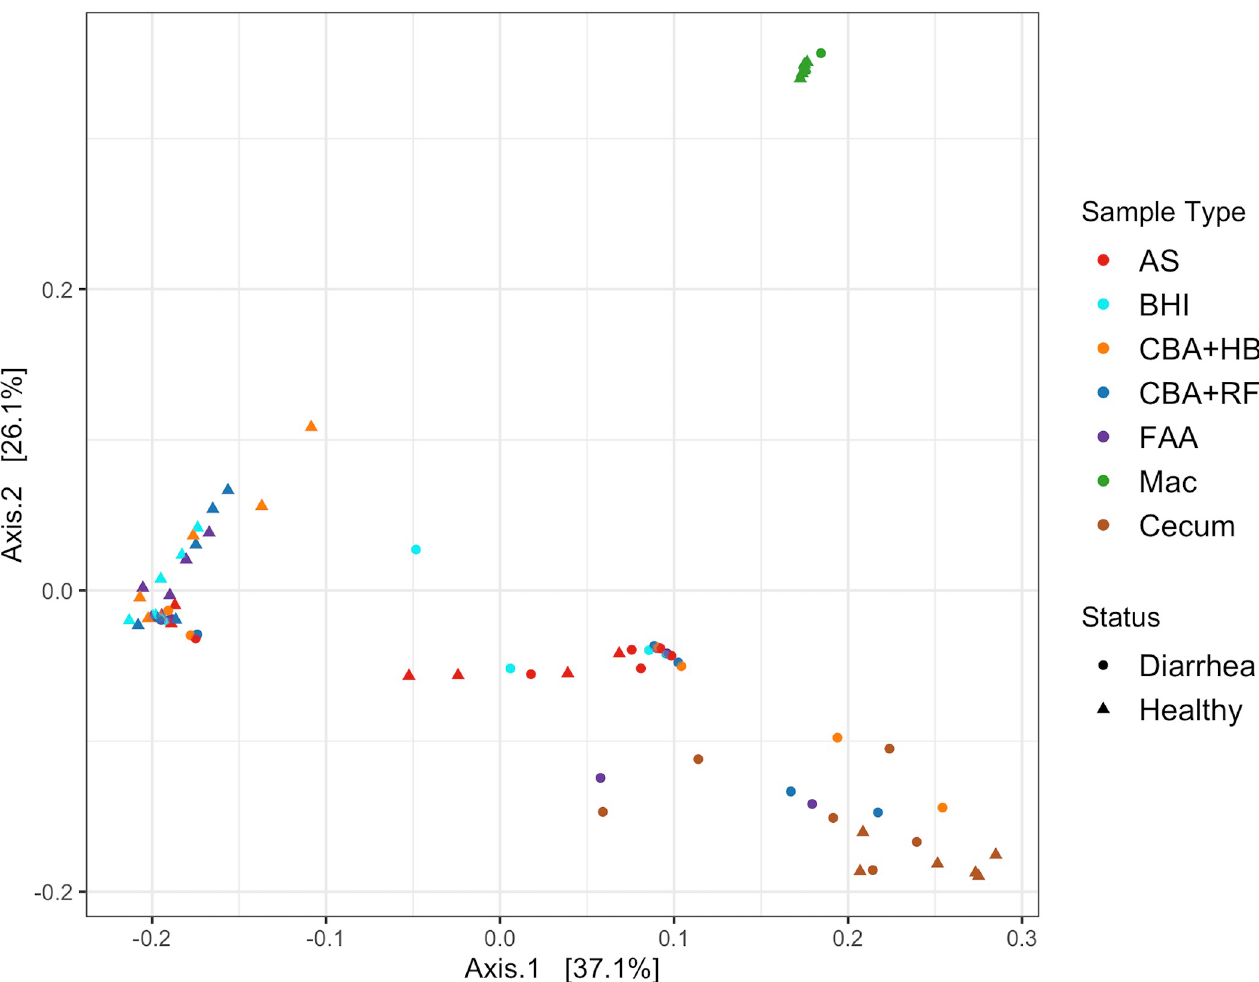
Fig 3. Principal coordinate analysis (PCoA) Plot generated on weighted UniFrac distances of cecal samples from healthy horses and horses with acute colitis either sequenced directly (cecum) or after selective media culture (Mac, FAA, CBA+HB, CBA+RF, BHI and AS). Abbreviations: MacConkey agar (Mac), fastidious agar with horse’s blood added (FAA), Columbia agar with horse’s blood added (CBA+HB), Columbia agar with rumen fluid added (CBA +RF), BHI3 with carbohydrate added (BHI), AS (samples plated on CBA+HB after alcohol shock), and Cecum (samples sequenced directly, without culture).